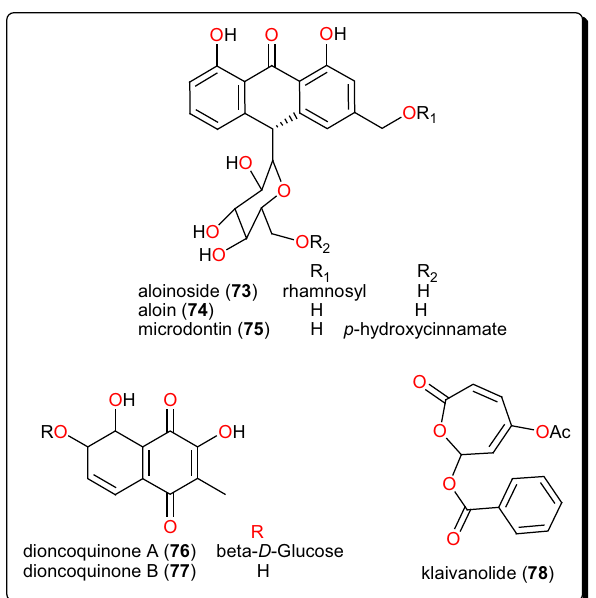
Fig. 14 Quiniones and klaivanolide, which showed lower micromolar activities against against several Leishmania species